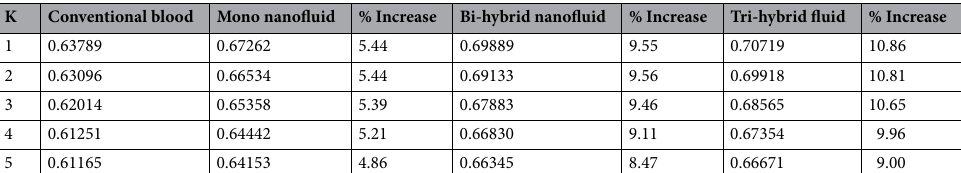
Table 2. The Nusselt number for pure blood, mono nanofluid, bi-hybrid nanofluid, and tri-hybrid fluid at fixed values of Ha = 1, R n = 2, U HS = − 1 and S p = 0.5